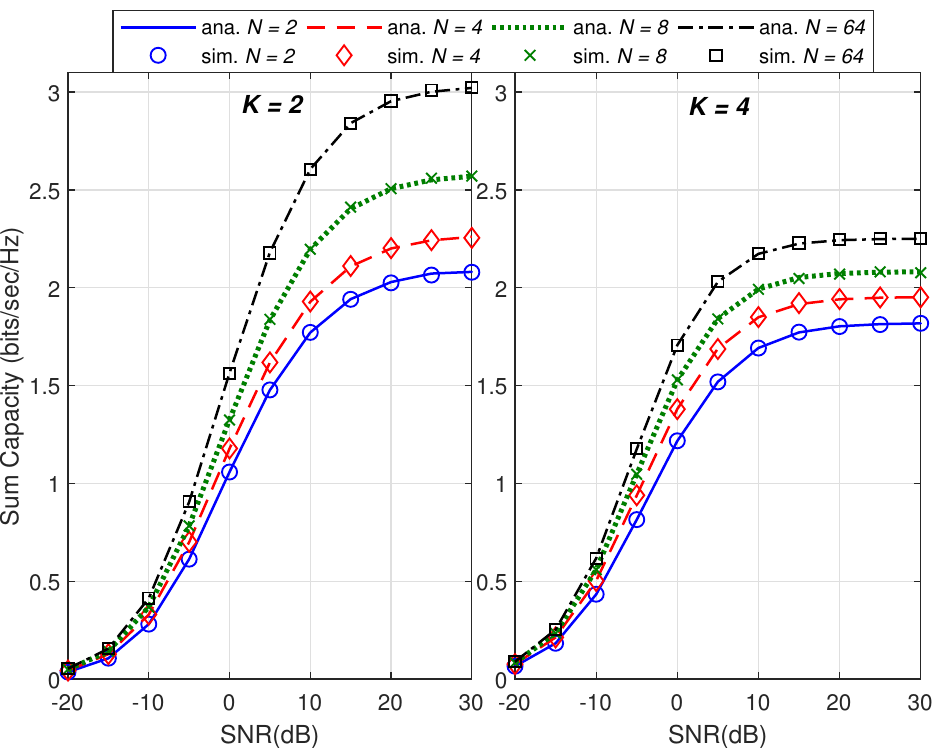
Figure 1. Comparison of analytical and simulation results of the sum capacity versus the transmit SNR in dB.